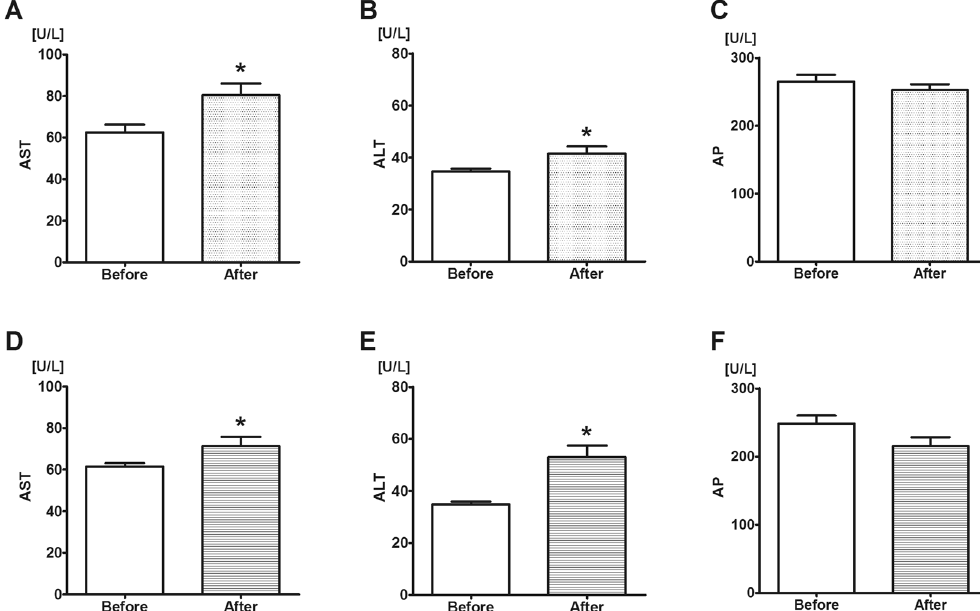
Figure 6. Liver-specific enzyme levels before and after alcohol consumption in rats. Enzyme levels were determined in plasma from blood samples taken on days 1 (untreated control, left boxes) and 8 (last day of alcohol treatment, right boxes) of the investigation. The 1.15 g/kg/day alcohol (panels A–C) and 1.15 g/kg/day alcohol + GPC-fed group (panels D–F) were monitored with same method. Both Aspartate aminotransferase (AST, panels A and D) and Alanine aminotransferase (ALT, panels B and E) levels increased significantly as compared to baseline. Alkaline phosphatase (AP, panels C and F) levels did not change. Mean values and standard error of mean (SEM) are given; * p < 0.05 vs . day 1 (Control). Statistics: Paired